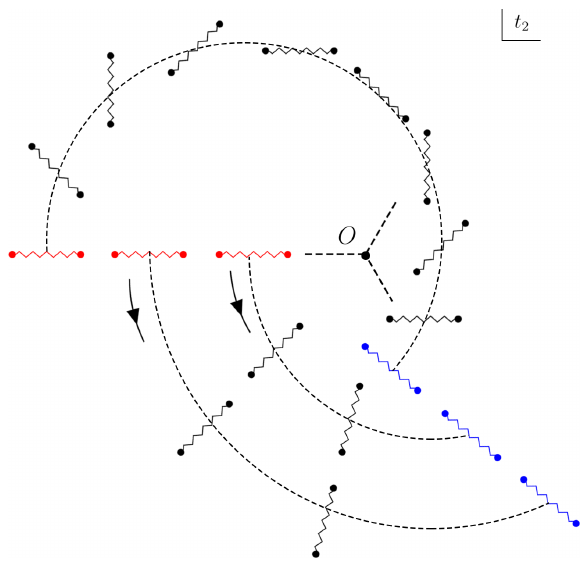
Figure 18 . The transformations of branch cuts on the t 2 -plane following the path from O B to O A on the U -plane for SU(3) 1